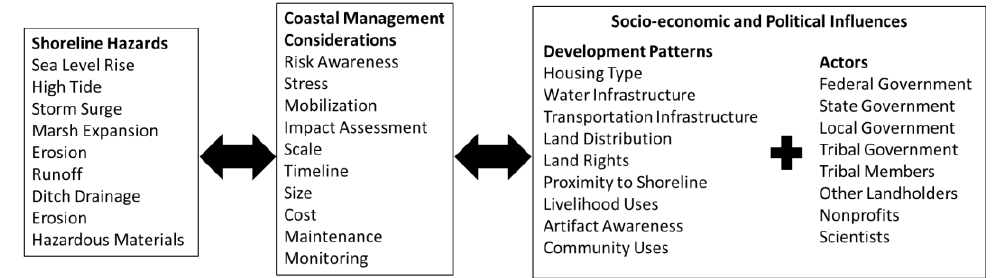
Figure 4. Contributors to management considerations on coastal reservations.